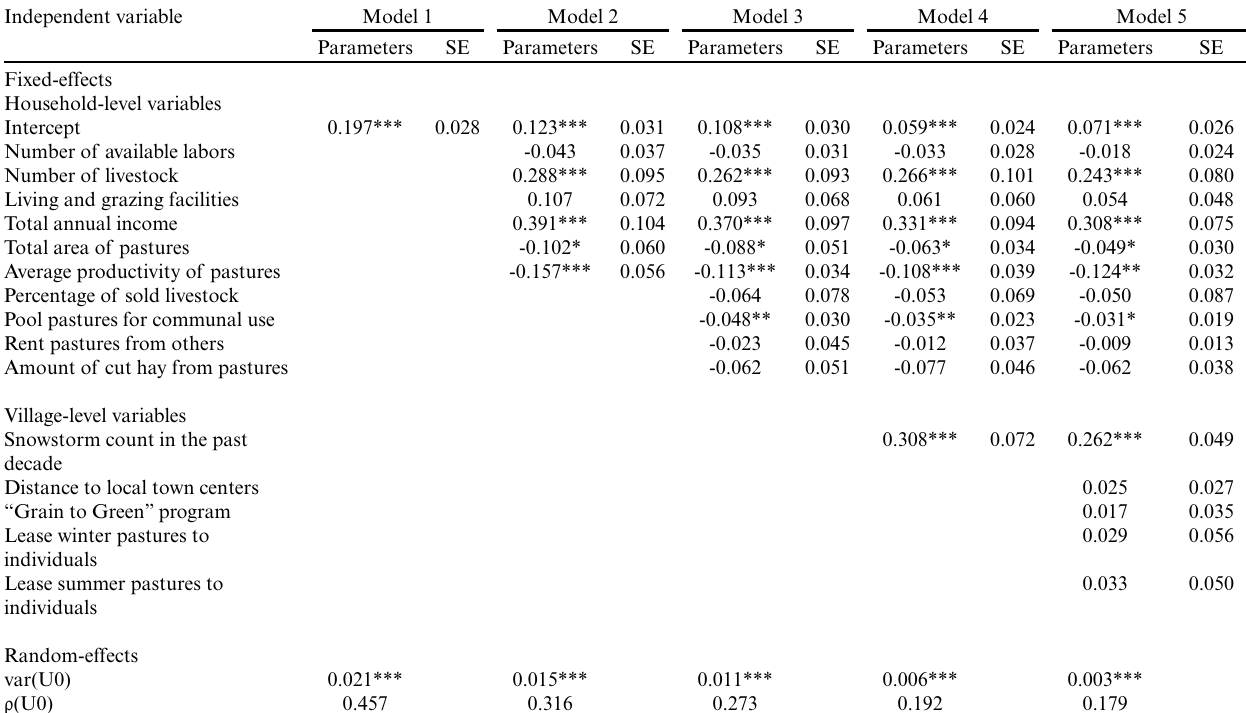
Table 3 . The estimates of multilevel regression models used for identifying the determinants of forage purchasing